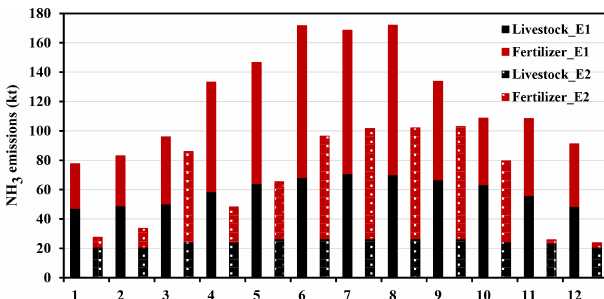
Figure 4. Monthly NH 3 emissions from fertilizer use and livestock farming in E1 and